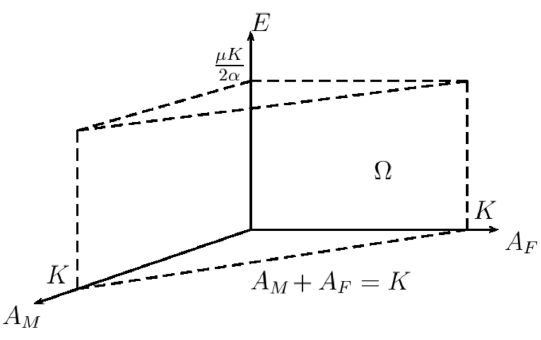
Fig. 3. Region where (4) is positively